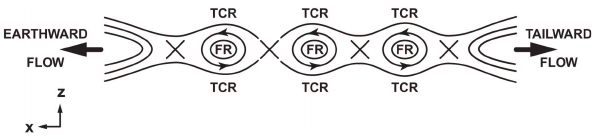
Fig. 11. Simultaneous reconnection at N+1 X-lines will convert the closed magnetic fields in the thinned plasma sheet into N flux ropes, plus some newly created closed (left-hand side of figure) and interplanetary (right-hand side) flux tubes. Flux ropes sunward of the NENL will be carried earthward as BBF-type events and those anti-sunward will be swept tailward as plasmoid-type flux ropes. Figure from Slavin et al. (2003c)